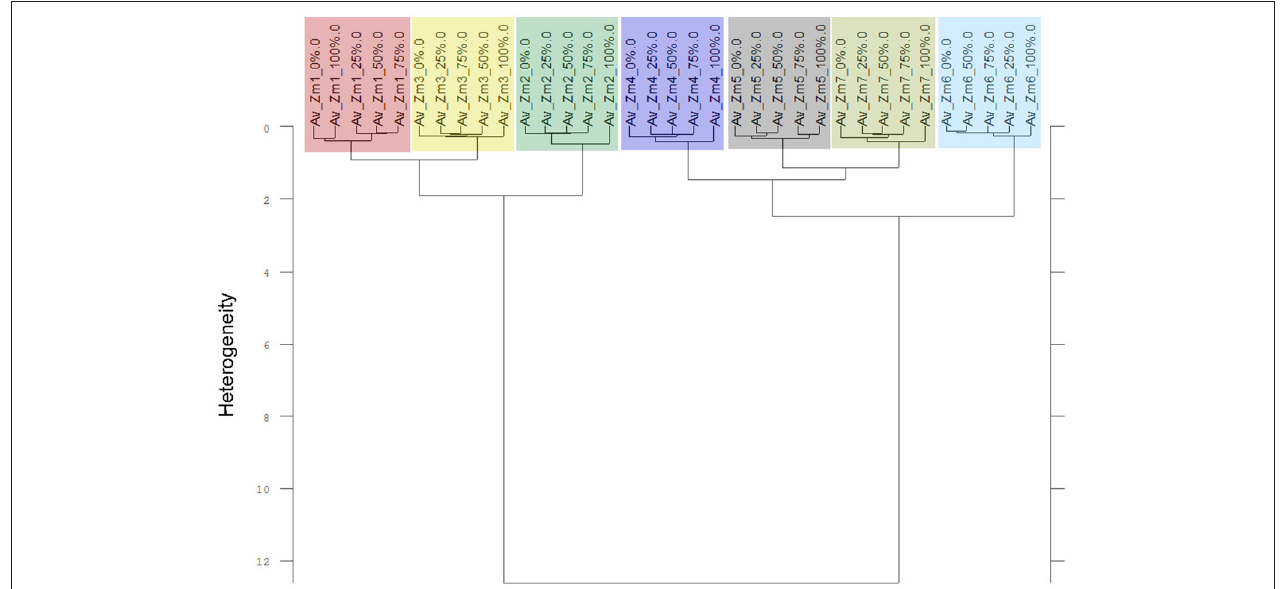
FIGURE 10 | Cluster analysis of the Av-spectra of all cultivars of the species Zea mays (Zm, maize) for the experiment 2-2. The reduced frequency range (3,751–2,749 cm − 1 and 1,801–599 cm − 1 ) of the Av-spectra was evaluated with the second derivation and vector normalization, Ward’s algorithm und Euclidian distance. The Av-spectra are averages (Av) of FTIR-ATR spectra of the different root segments (100% root tip, 0% root basis etc.; see Figure 1 for scheme, Table 2 for n, Table 1 for names of cultivars and proveniences).